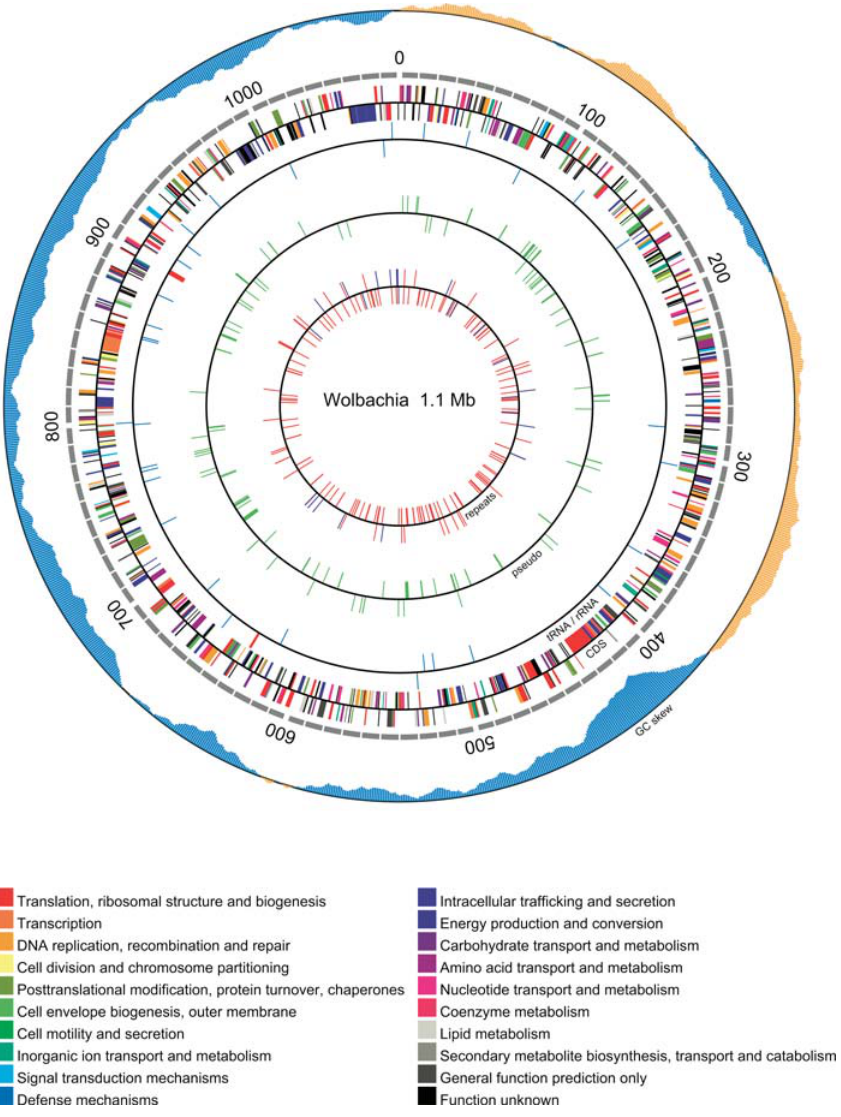
Figure 1. Genogram of the Complete Circular Genome of w Bm The scale indicates coordinates in kilobase pairs (kbp) with the putative origin of replication positioned at 0 kbp. The outermost ring indicates the GC-skew over all bases in the forward strand using a window size of 40 kbp and a step size of 1 kbp. Positive and negative skew are shaded gold and blue, respectively. Features are shown as paired rings separated by a circular baseline. In each pair, the outer and inner rings represent the forward and reverse DNA strands, respectively. Working inward from the scale, the features displayed are as follows: identified genes and their broad functional classification (multihued, as listed); tRNA (blue)/rRNA (red) genes; putative pseudogenes (green); repeated sequences (red) and transposon-related repeats (blue). DOI: